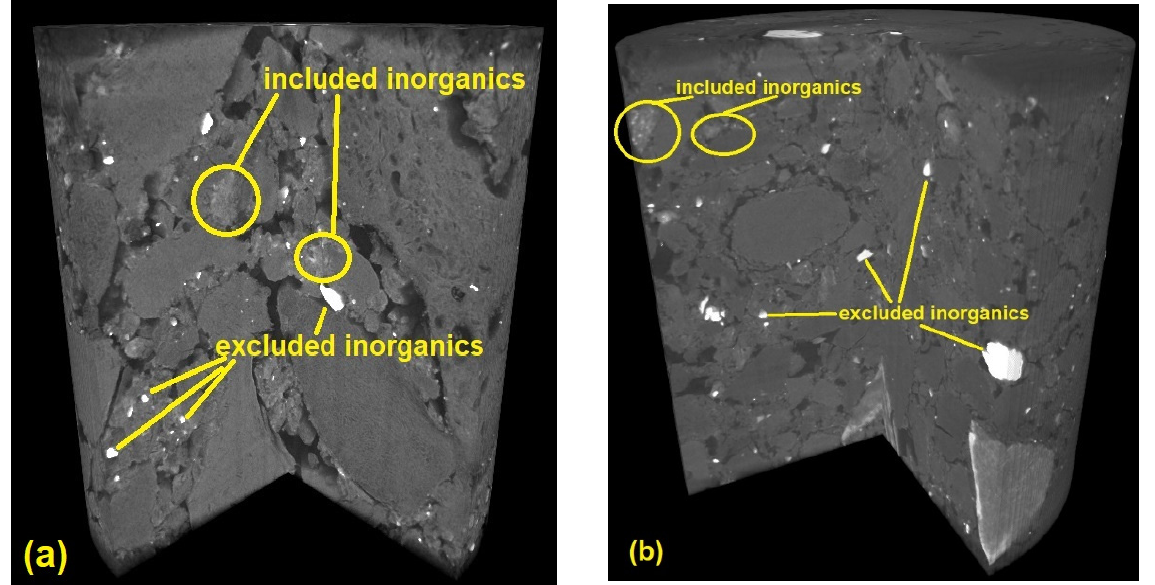
Figure 3. X μ CT imaging analysis showing included and excluded inorganic matter for ( a ) olive stone and ( b ) anthracite [37].